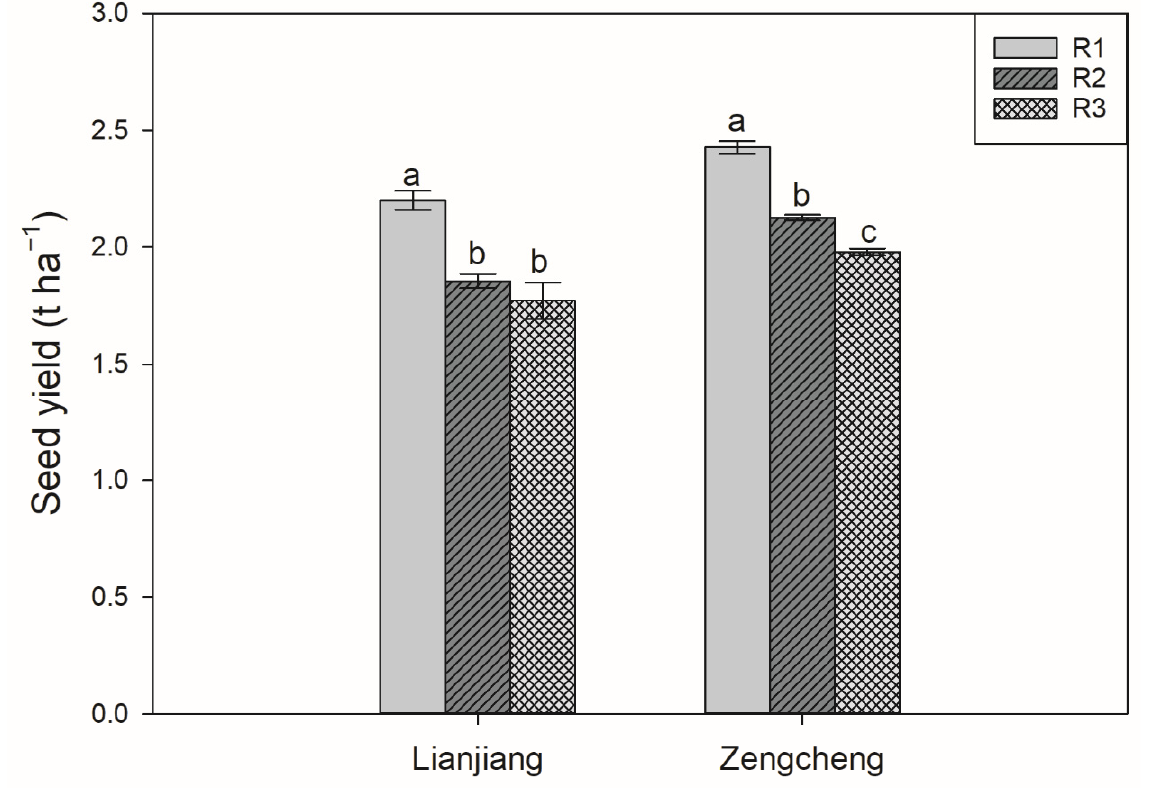
Figure 3. Effects of different parents’ ratios on seed yield of hybrid rice seed production. Seed yield was at 14% moisture. The different letters above the column indicate a difference at p < 0.05 by LSD tests. Error bars represent standard error.